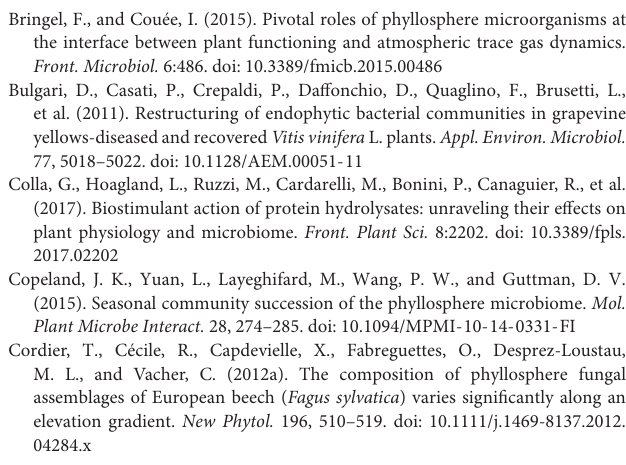
Supplementary Figure 1 | The shared and united operational taxonomic unit (OUT) among different gradients and growth stages. B, bacteria; F, fungi. M, seedling stage; G, heading stage; S, mature stage. (A) 580 m asl; (B) 680 m asl; (C) 780 m asl; (D) 880 m asl; (E) 980 m